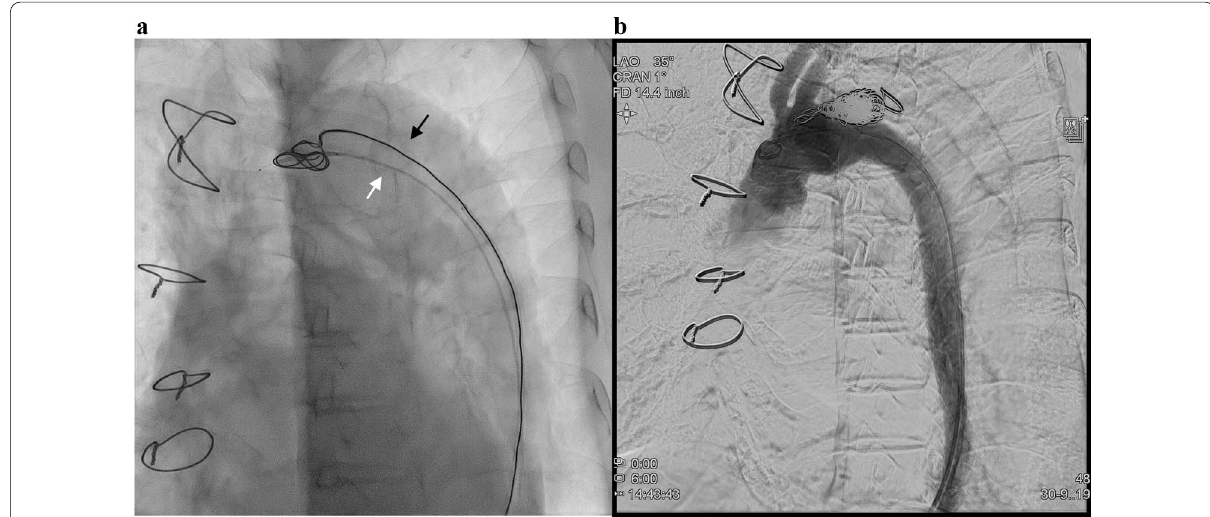
Fig. 3 Intraoperative angiography. a A catheter is inserted, and an Interlock-35 is placed as an anchor (black arrow). Next, a microcatheter is inserted via another catheter to perform coil embolization (white arrow). b The final aortography shows lack of blood flow in the false lumen. Final contrast enhancement shows no blood flow from the true to the false lumen